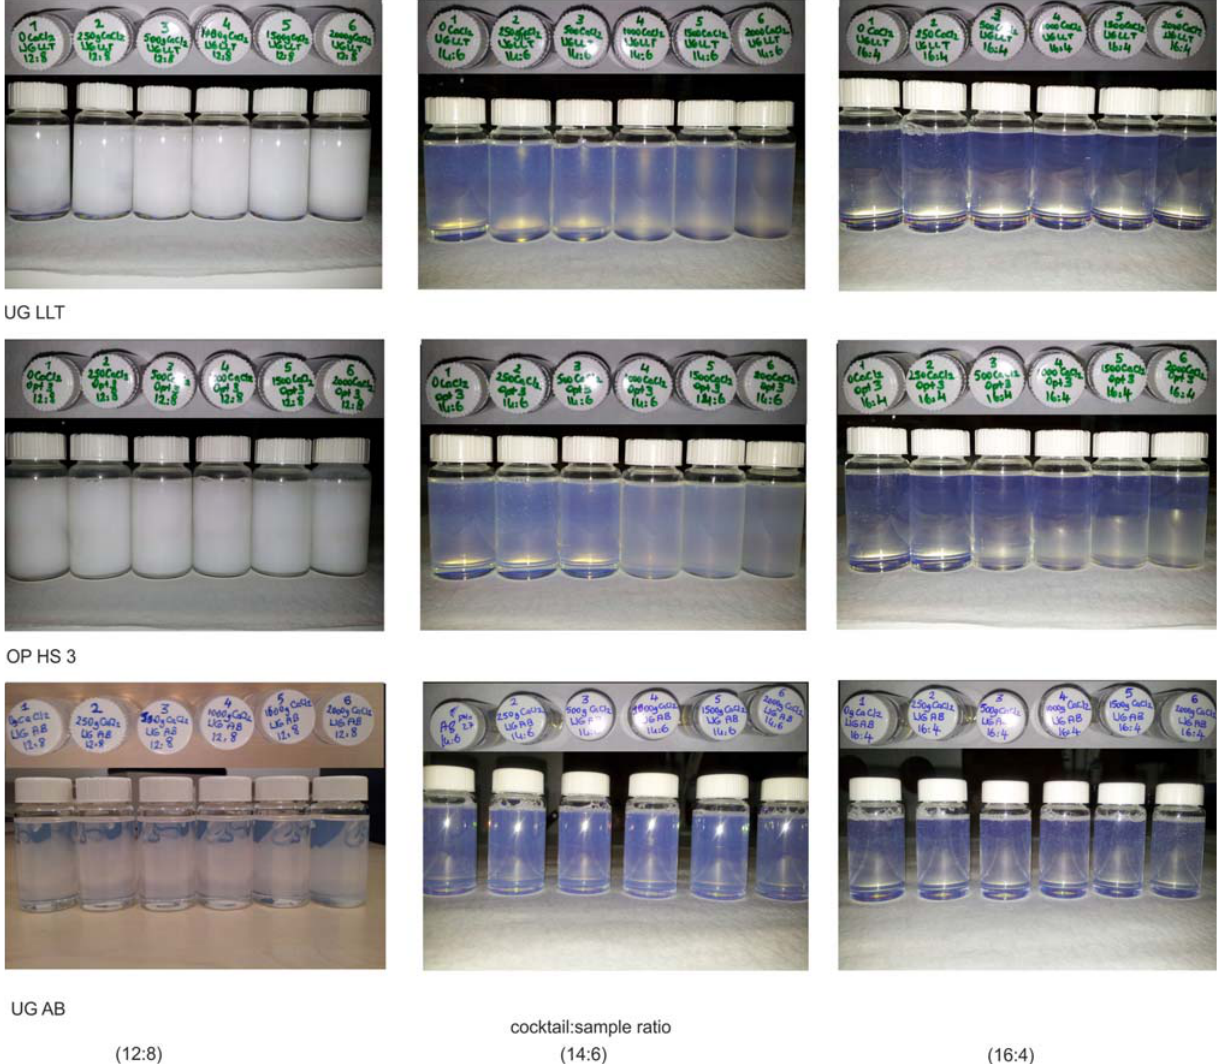
Figure 1. The effect of total dissolved salt concentration at different cocktail types and different cocktail: deionized water ratios (Vials from 1 to 6 contains 0, 250, 500, 1000, 1500, 2000 CaCl mg L –1 , respectively) 2